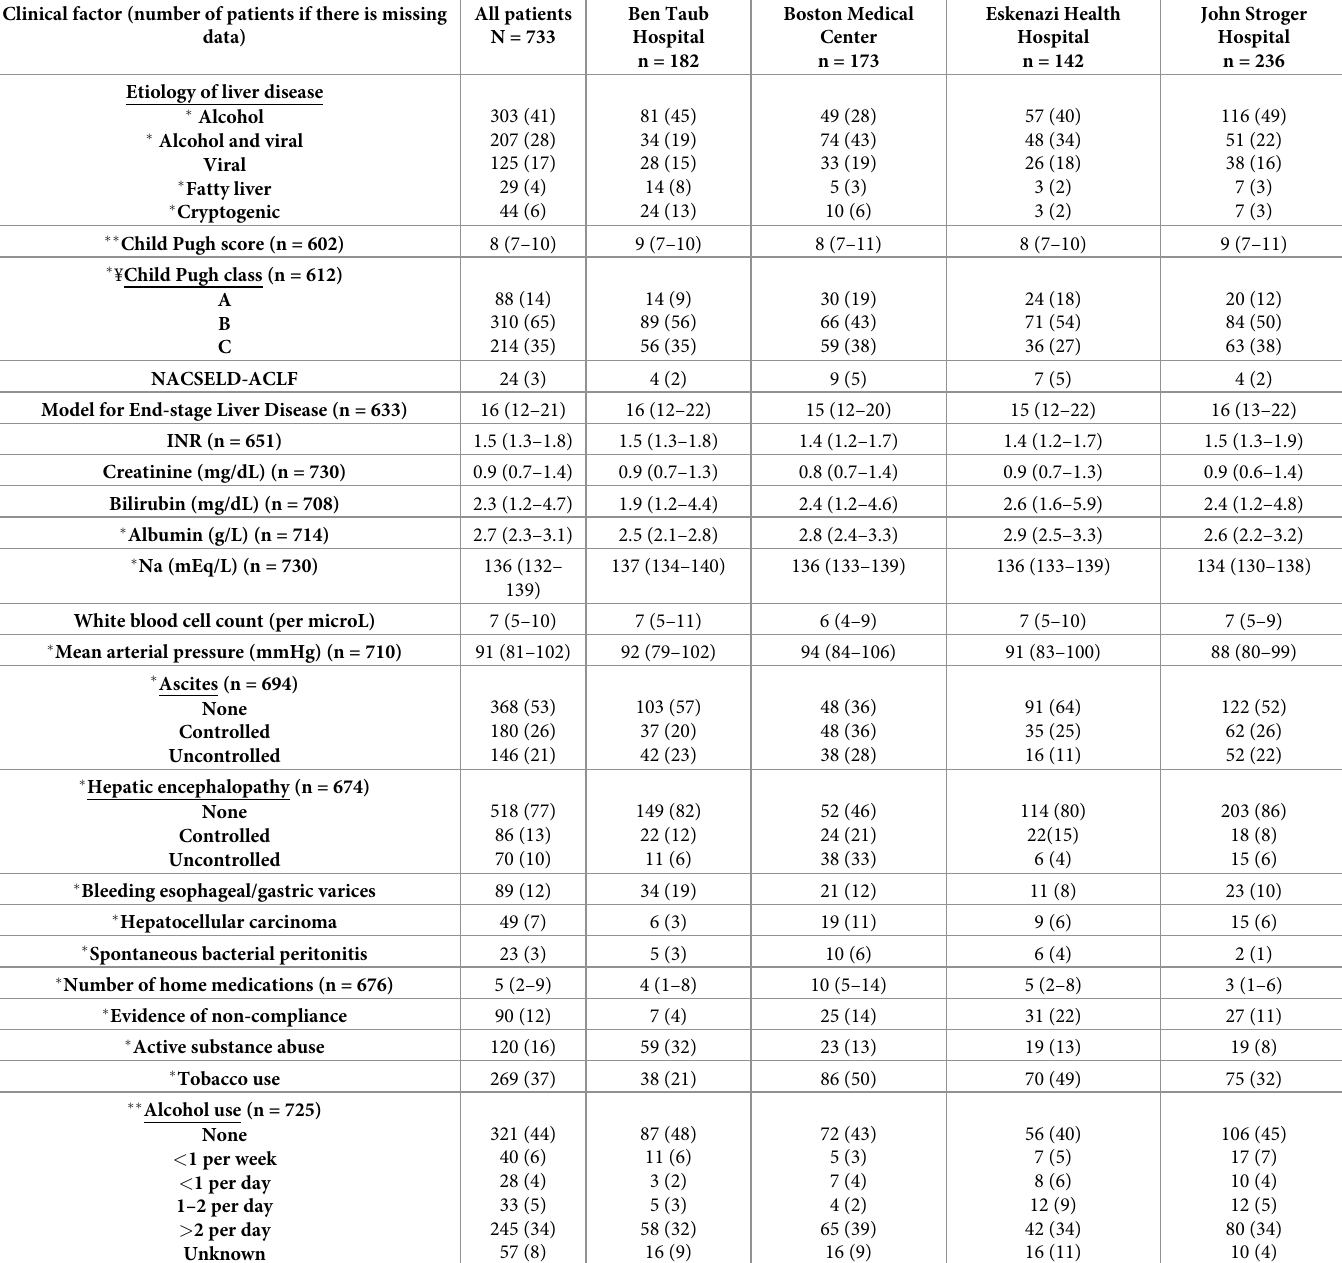
Table 2. Etiology and severity of liver disease on admission in the study cohort and in patients hospitalized at the respective study centers. Data are reported as num- ber (percent) or median value (interquartile range). Clinical factor (number of patients if there is missing